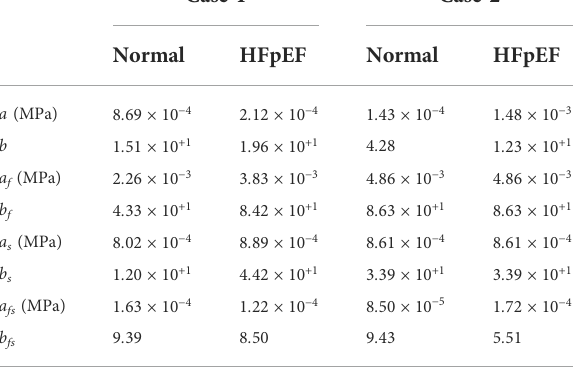
TABLE 4 The passive material properties for each cardiac model before and after the induction of HFpEF.